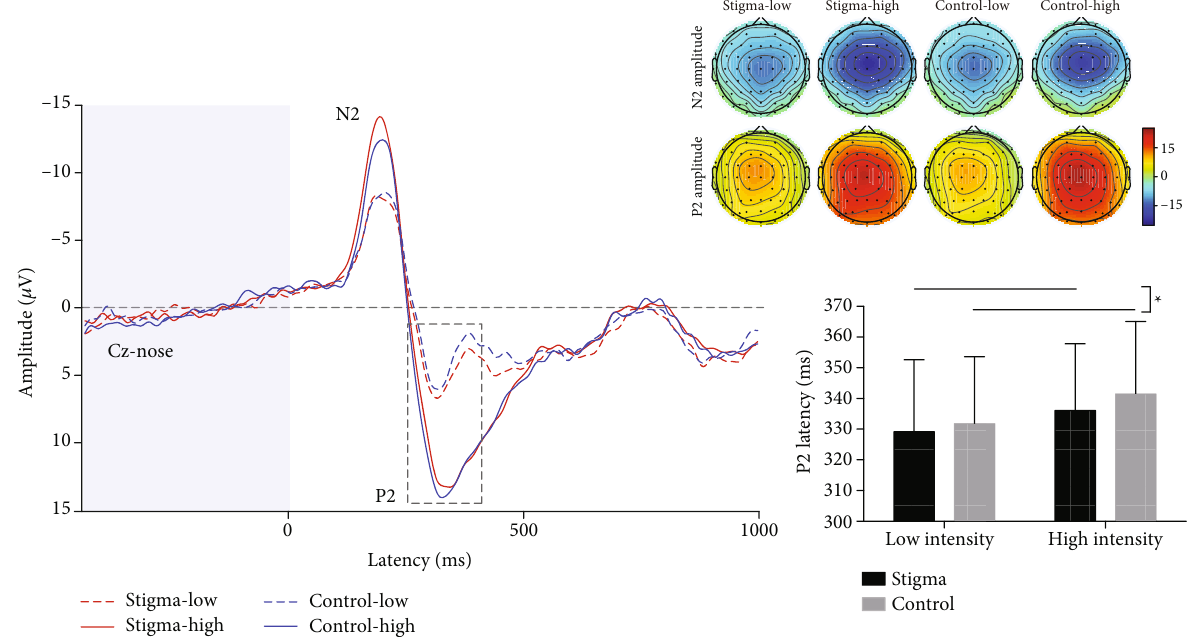
Figure 4: Laser-evoked potentials (N2 and P2 waves) in four experimental conditions. P2 latencies were signi fi cantly earlier in the stigma condition than in the control condition ( ∗ p ≤ 0 : 05 ). Scalp topographies of N2 and P2 waves in four conditions were displayed at their peak latencies.